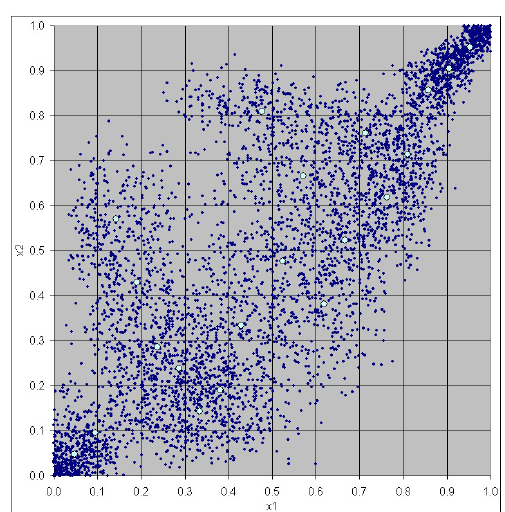
Figure 19. Gamma rook copula, a = 15.